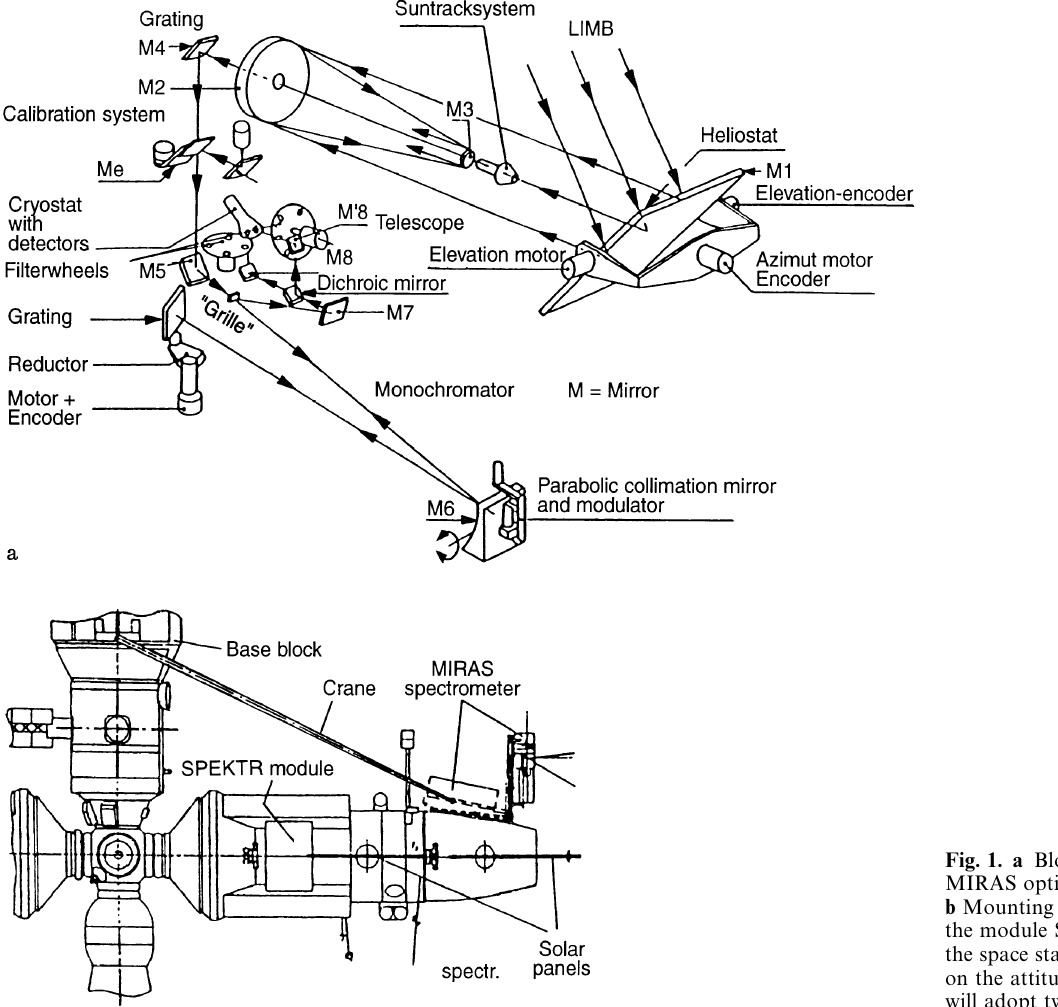
Fig. 1. a Block diagram of MIRAS optical